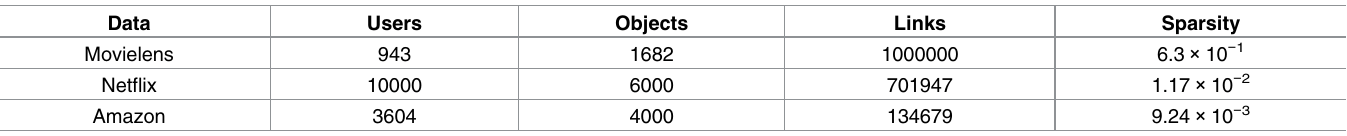
Table 3. Summaryon primary information of four